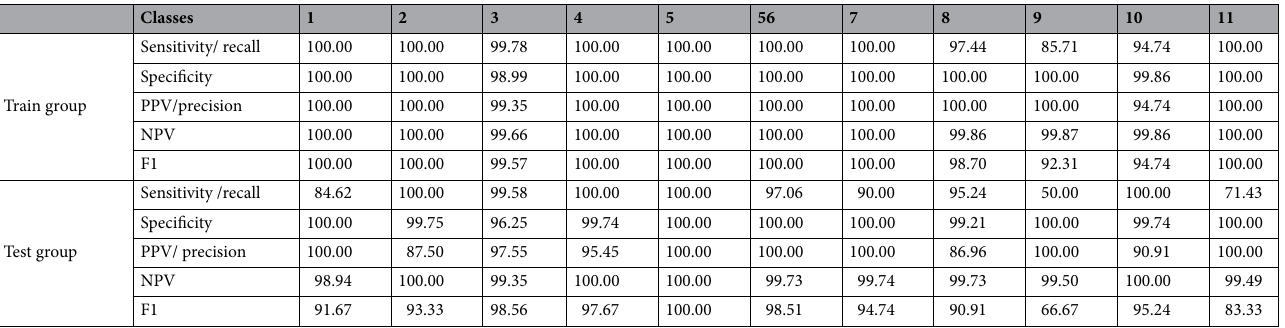
Table 6. Effects of AI prediction between train and test groups among various diseases in Project 4 (%). 1: Pediculosis and phthiriasis; 2: herpes simple genital; 3. lichen planus; 4: condilomas acuminados; 5. Ichthyosis; 6. viral exanthems; 7: pediculosis pubis; 8. pemphigus ; 9: Gonorrhea; 10: eczema; 11: sarna noruega; PPV positive predictive value, NPV negative predictive